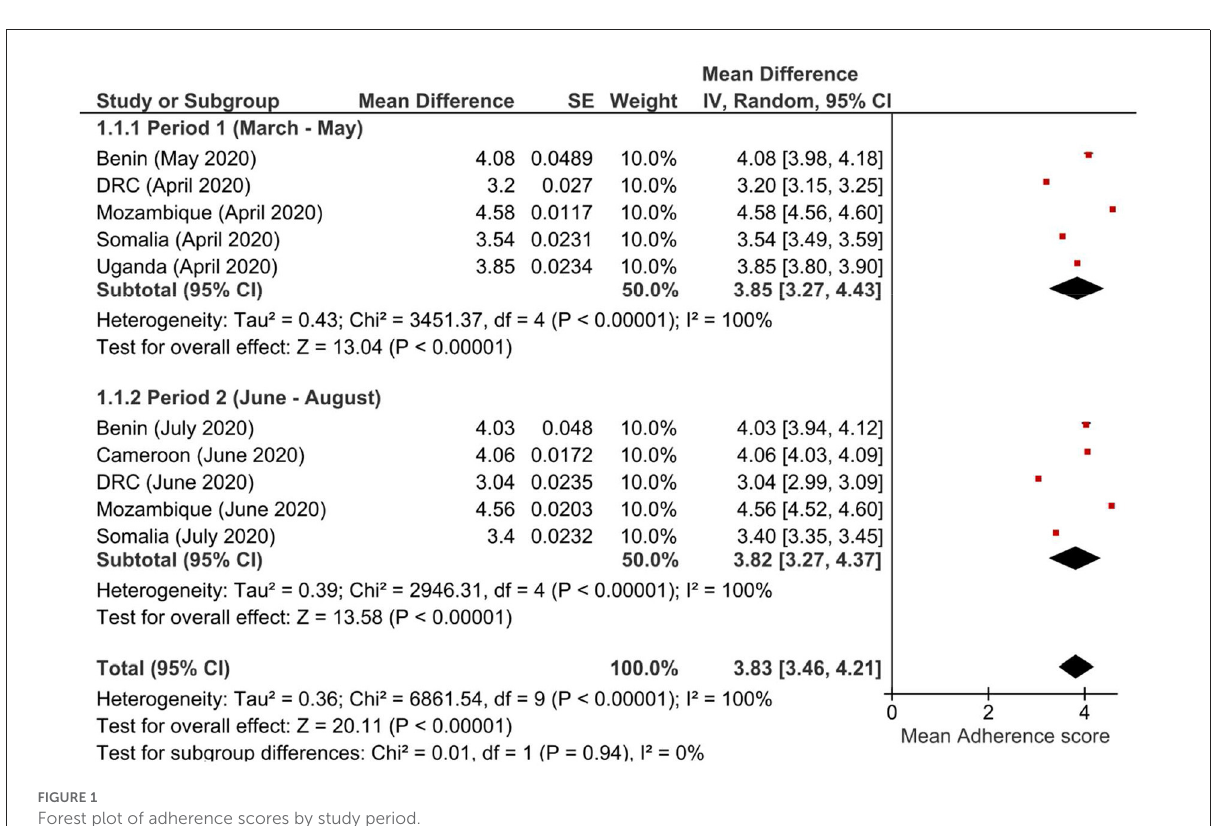
FIGURE1 Forest plot of adherence scores by study